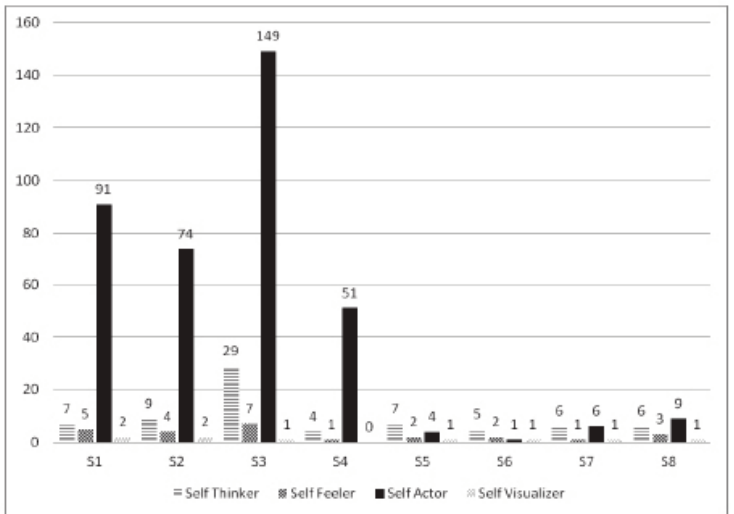
Figure 5. Numbers ofdifferent Imagine Other roles adopted by each participant across